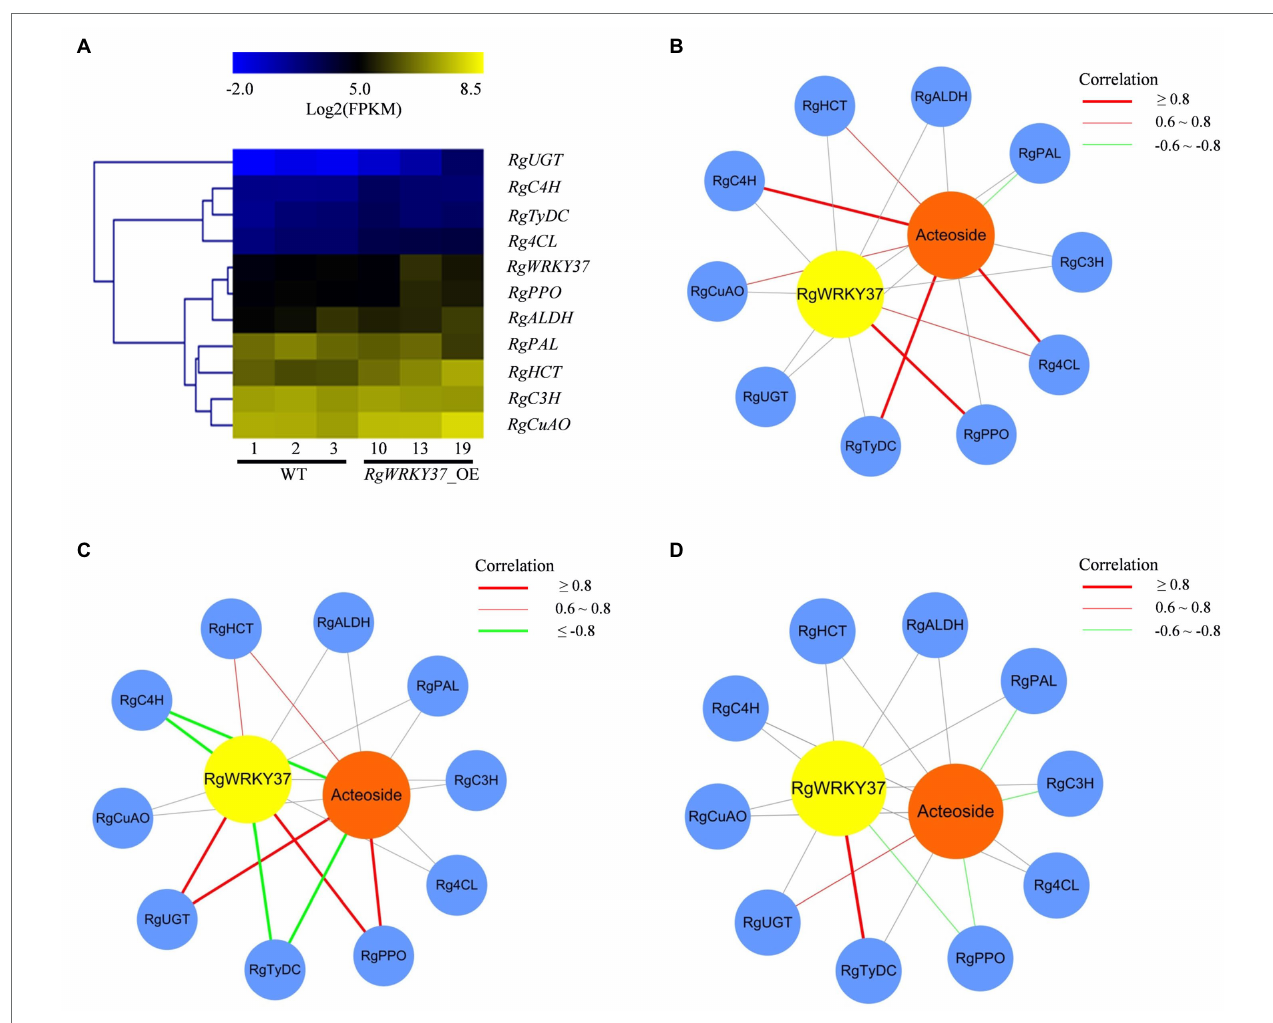
FIGURE 10 | Expression patterns of RgWRKY37 and enzyme genes involved in acteoside biosynthesis in hairy roots. (A) Heat map representing expression dynamics of RgWRKY37 and candidate enzyme genes in transgenic lines. (B) Gene-acteoside correlation network for transgenic hairy root lines. (C) Gene- acteoside correlation network for SA-treated hairy roots. (D) Gene-acteoside correlation network for H 2 O 2 -treated hairy roots. Genes and acteoside are drawn as blue, yellow, and orange circles, respectively. The red lines indicate positive correlation, the green lines indicate negative correlation, and the gray lines indicate the lack of correlation. Pearson correlation coefficient values were calculated for each gene/metabolite